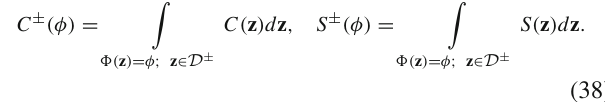
tributions for the D → K 0